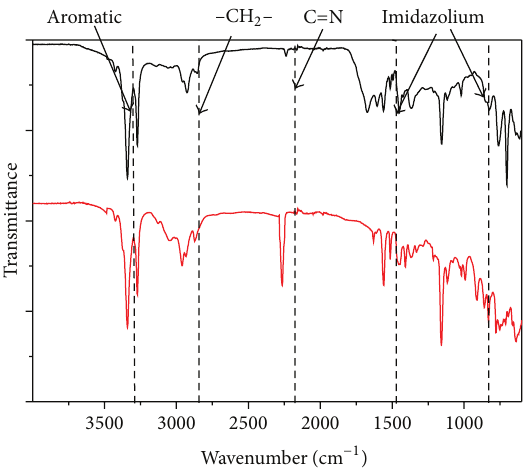
Figure 2: FT-IR spectra of [BVBI][Cl] (black line) and anion- exchange membrane (red line).